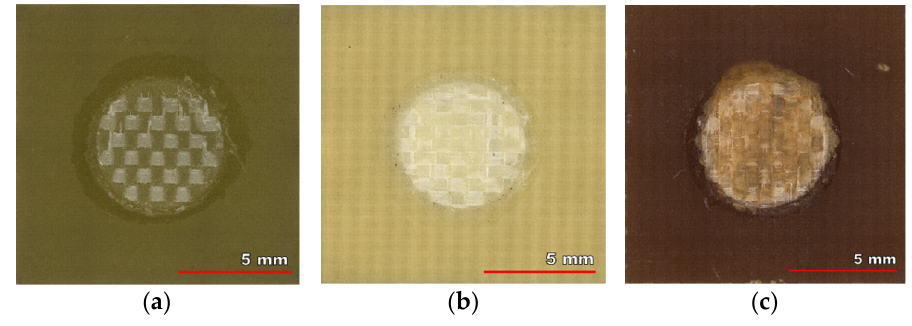
Figure 8. Exposed glass cloth after tearing the pad: ( a ) FR4 low Tg; ( b ) FR4 high Tg; ( c ) G30.